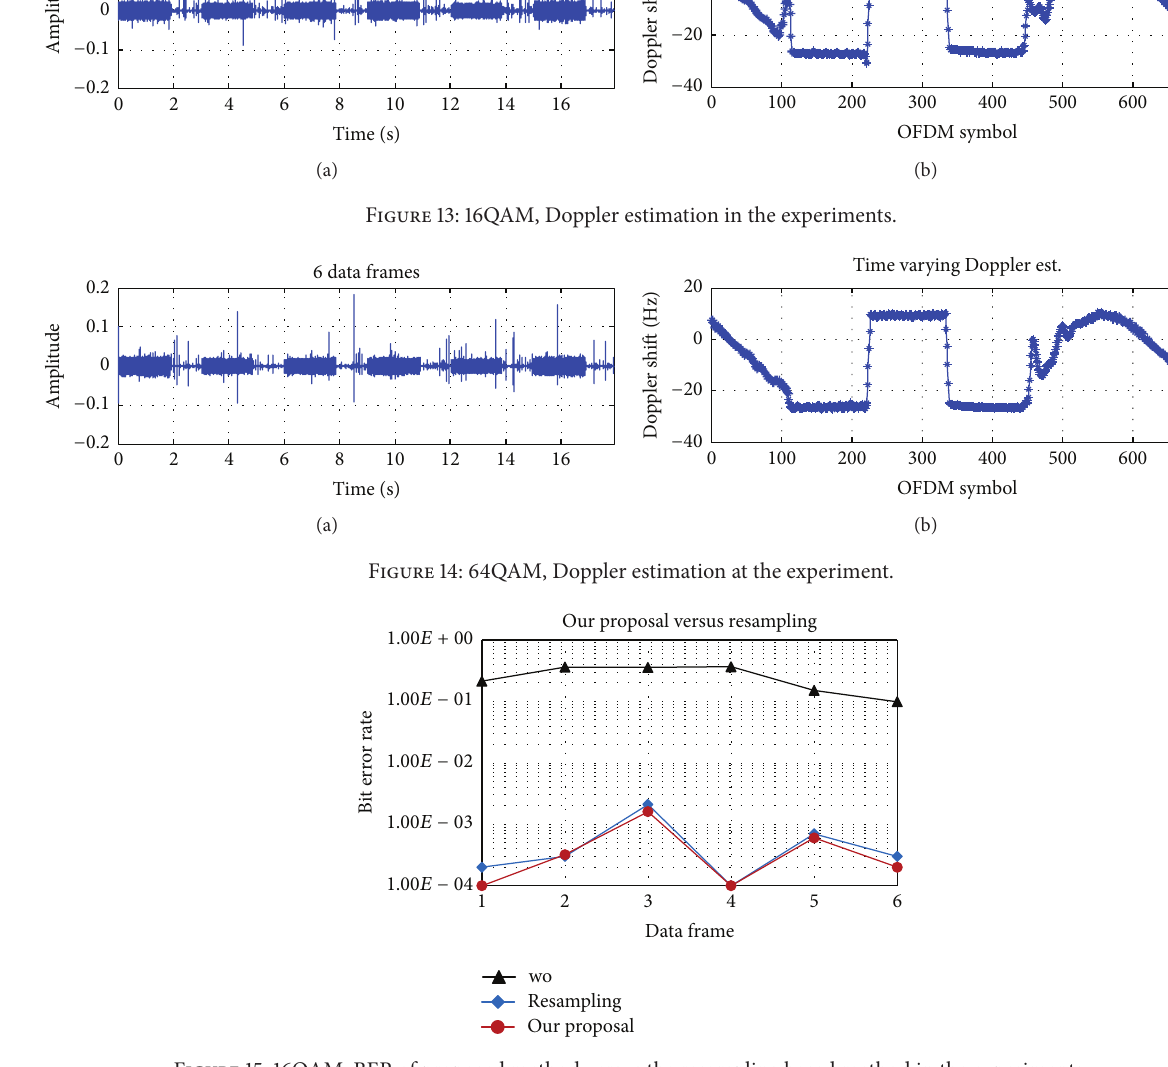
Figure 15: 16QAM, BER of proposed method versus the resampling based method in the experiments.